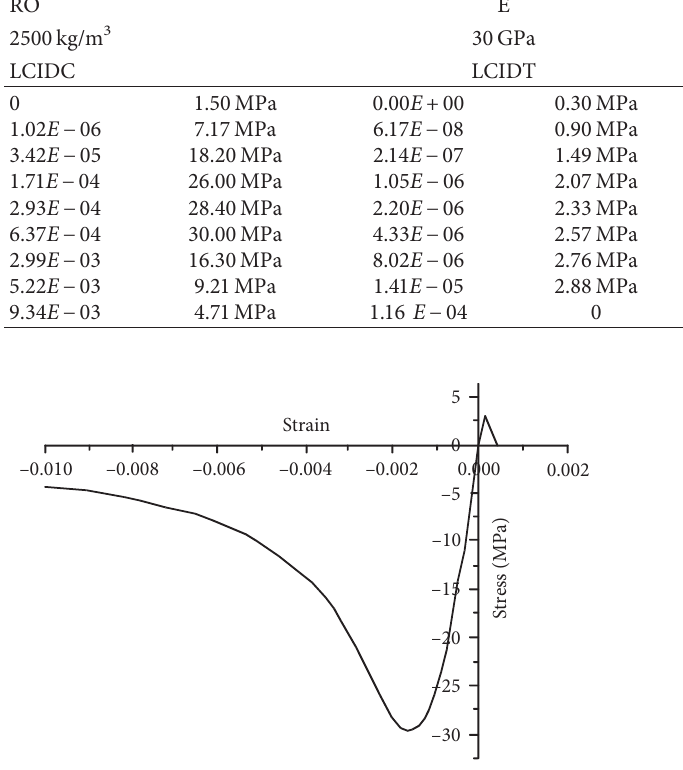
Figure 7: The complete stress-strain curve of C30 concrete under uniaxial action. Table 2: Simplified model mechanical parameters of the reinforced concrete axially compressed short column.